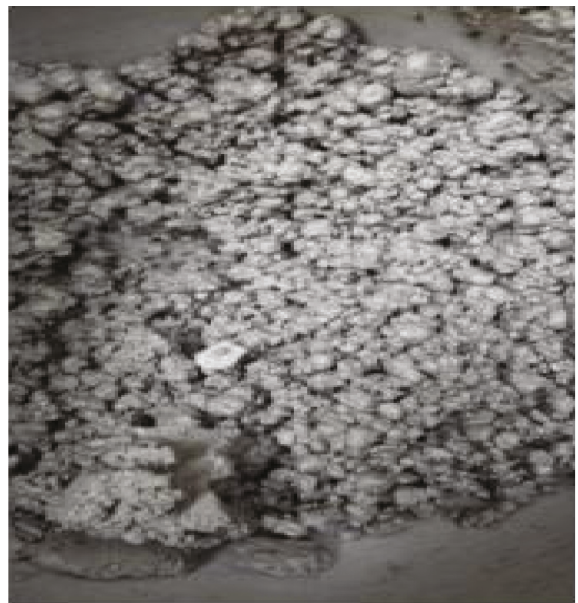
Figure 8: Solid particle.